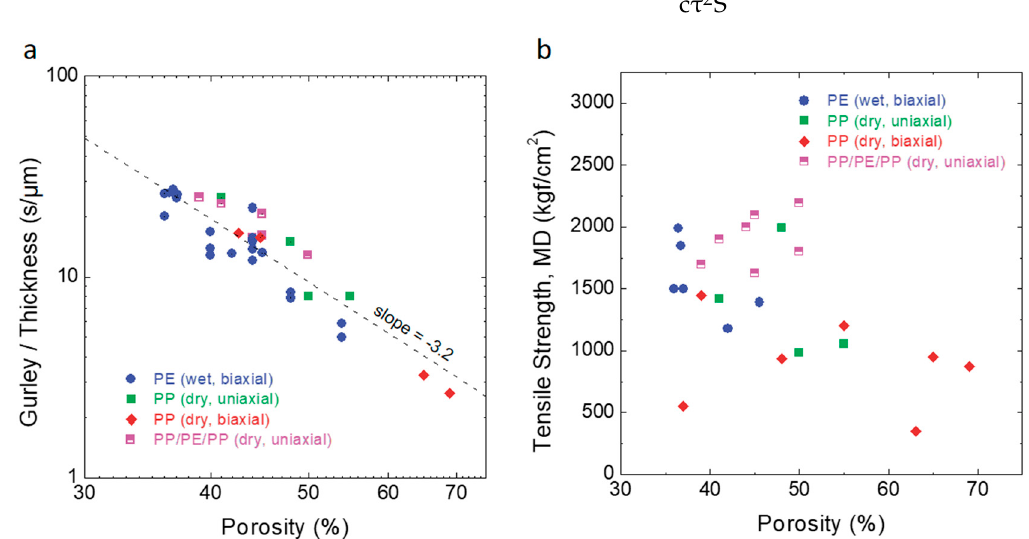
Figure 9. Correlation between porosity and ( a ) the Gurley/thickness (log-log plot) [5,13,14,45,59–61,70–73] and ( b ) tensile strength in the MD of microporous polyolefin separators [5,14,24,45,59,61,63,64].